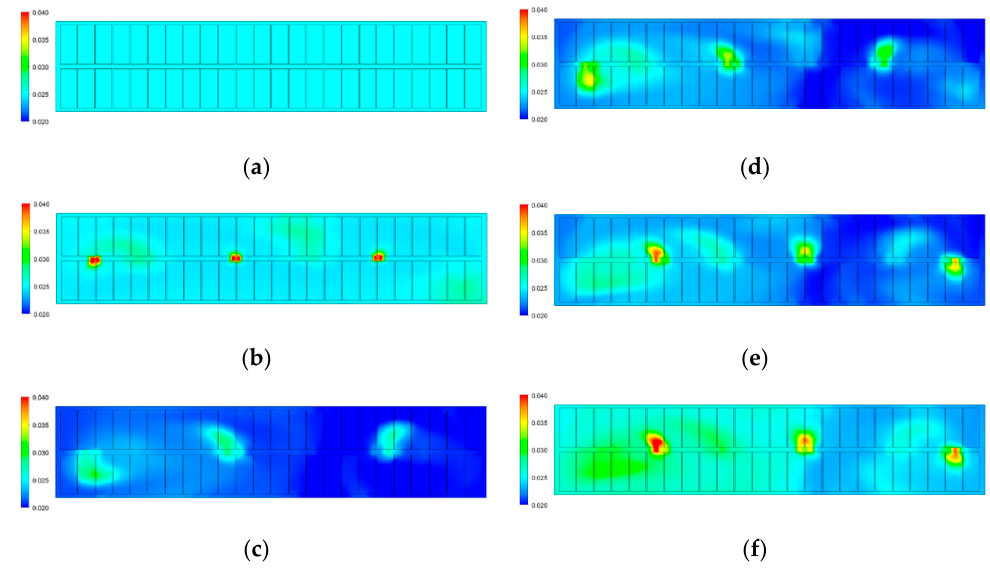
Figure 5. Alumina distribution in the horizontal plane in the middle of the ACD for the unslotted case 0: ( a ) t = 0 s, ( b ) t = 60 s, ( c ) t = 2700 s, ( d ) t = 3180 s, ( e ) t = 3420 s, ( f ) t = 4860 s.